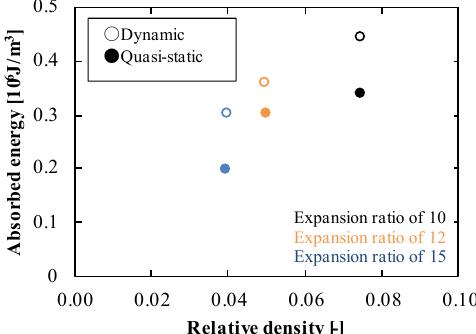
Fig. 8. Relationship between absorbed energy and relative